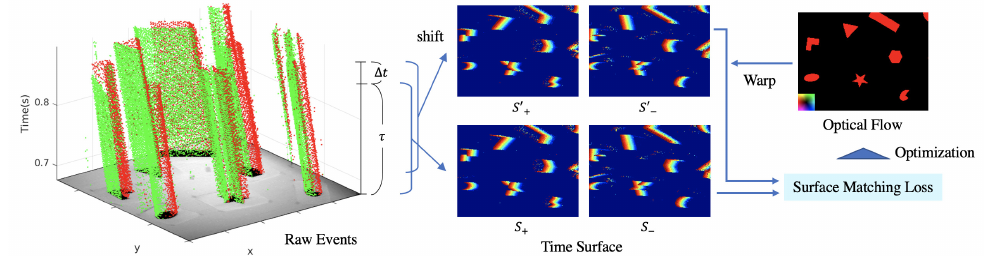
Figure 1. Overview of the proposed method. Left : The plot of the real event data [13] taken by DAVIS [14] in x − y − t space. The red and green dots indicate the positive and negative events respectively. Middle : Time surface and shifted time surface ( upper and bottom ) at each polarity ( left and right ). The event timestamp is color-coded (with red for the most recent and blue for the oldest part of the time surface). The brackets represent the time width in which the time surface is formed. Right : Warp the time surface by the optical flow parameters, measure the matching cost, and minimize